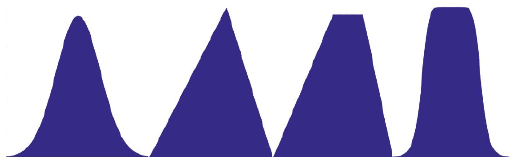
Figure 6. Some examples of ink drop patterns with the Ink-diameter of IDS.